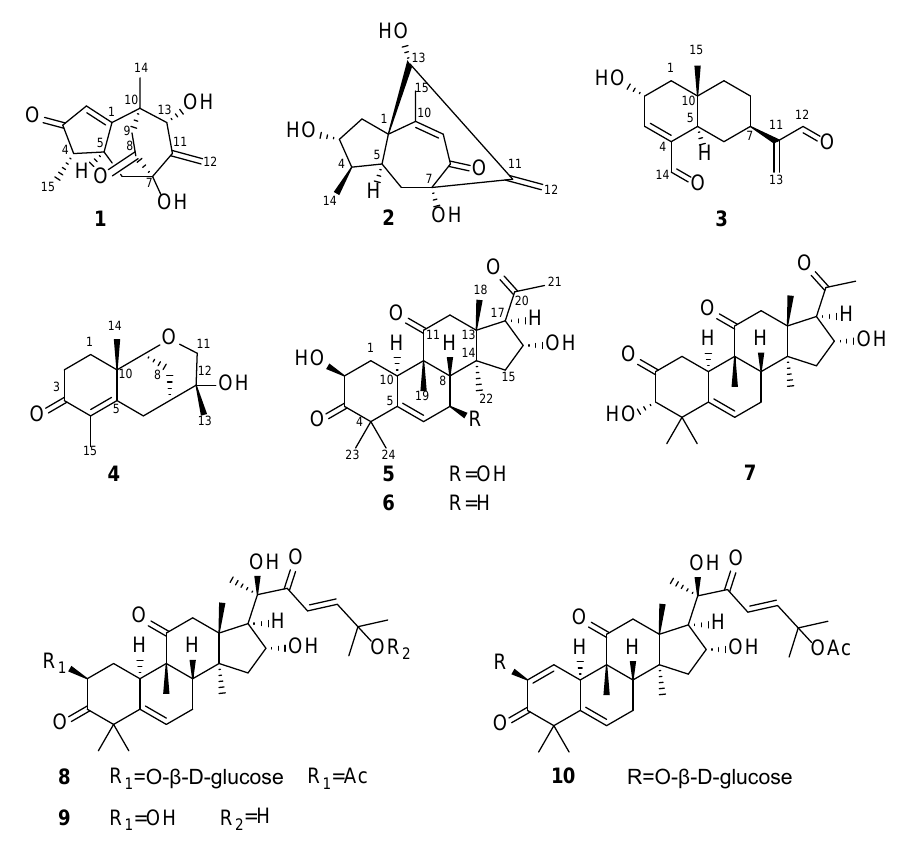
Figure 1. The structures of compounds 1 – 10 .